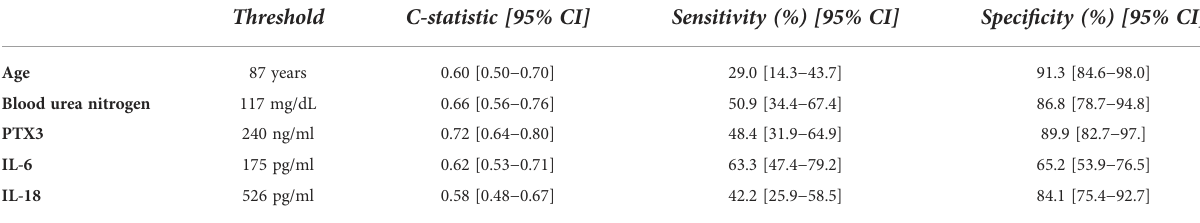
TABLE 7 Harrel C-statistics, sensitivity and speci fi city of each predictor included in the multivariable Cox model of 90-days